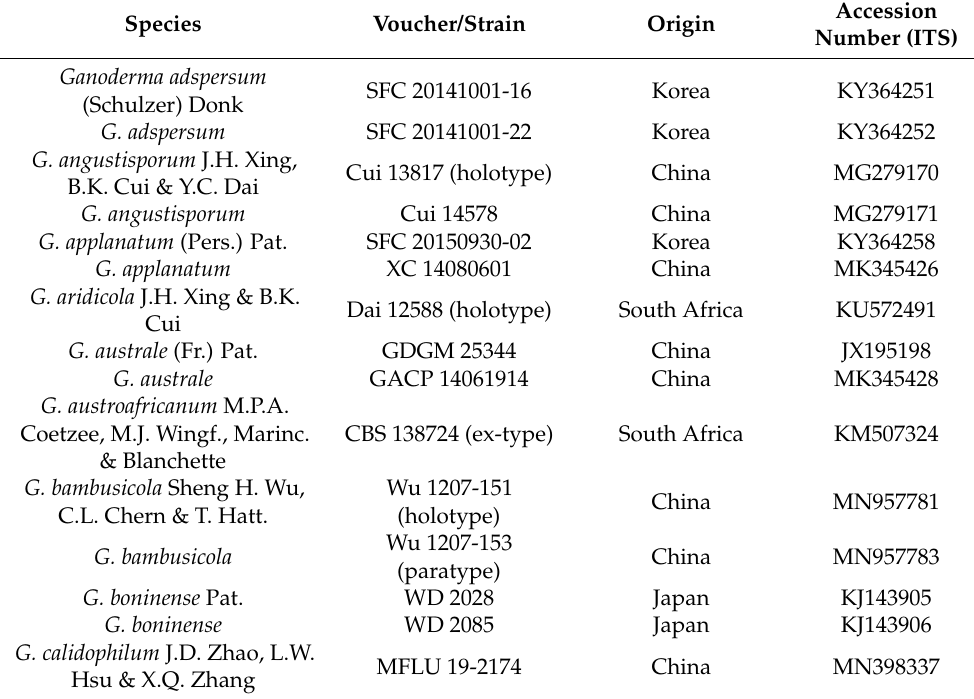
Table 3. Strains and GenBank accession numbers used in this